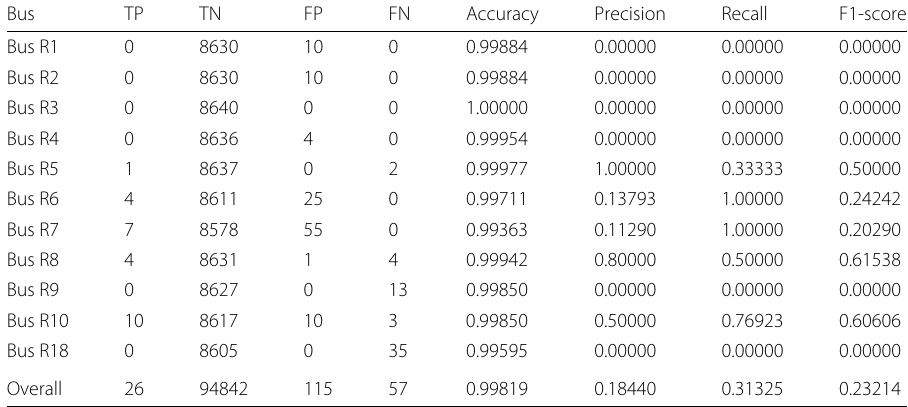
Table 4 Summary of the domain-specific